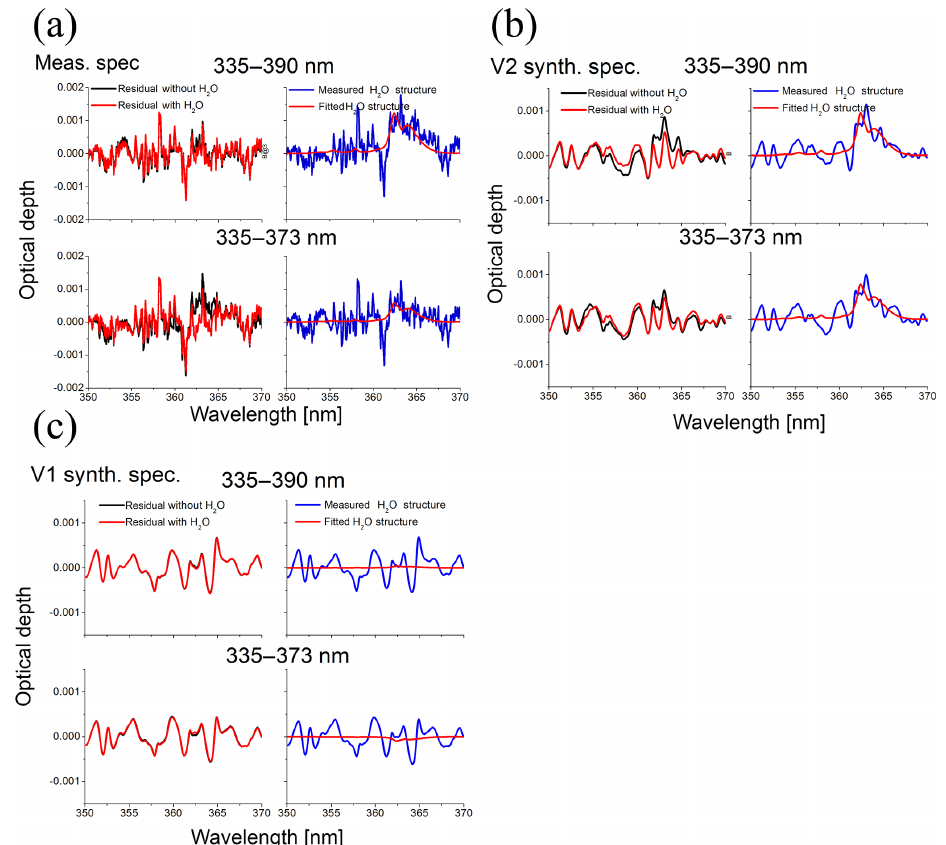
Figure 10. (a) Residual structures (left) and H 2 O fit results (right) for the same measured spectrum as in Fig. 9 for the fits either with (red) or without (black) the POKAZATEL H 2 O cross section. The upper and lower two subfigures represent fits in the spectral range of 335–390nm and 335–373nm, respectively. Panels (b, c) are same as (a) , but for the V2 and V1 synthetic spectra for a SAA of 166 ◦ and EA of 1 ◦ ,